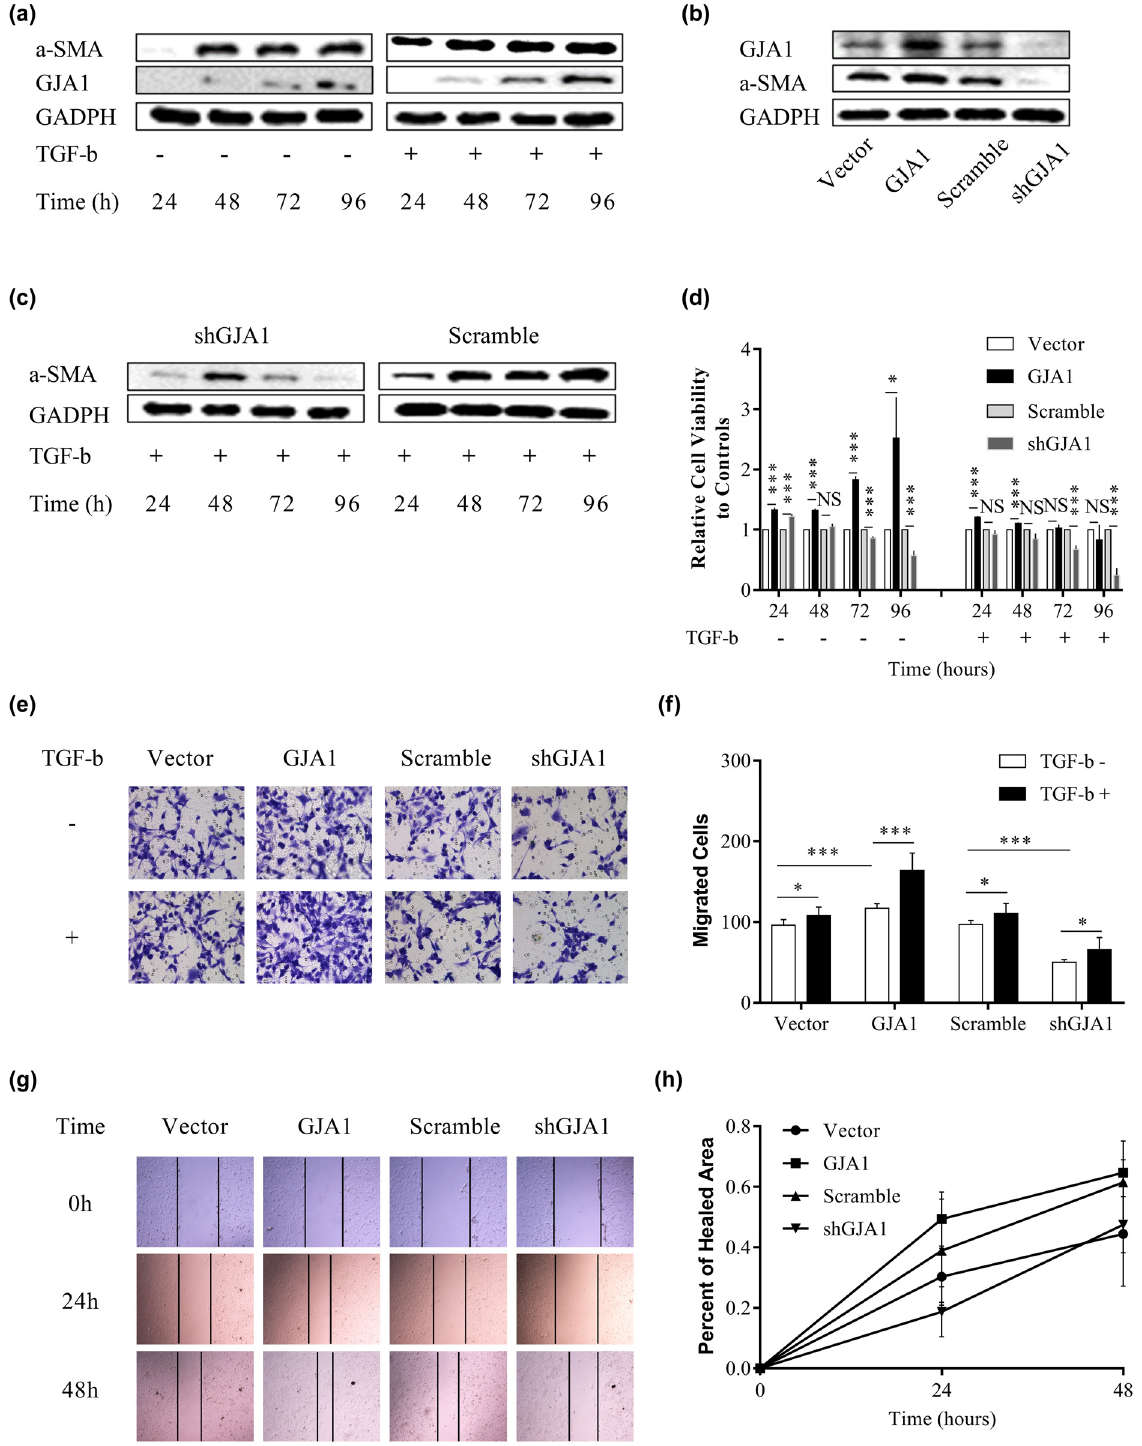
Figure 2: TGF - β - mediated HSC activation and migration are dependent on GJA1. LX2 cells were stimulated with or without TGF - β for 24, 48, 72, and 96h, and cell lysates were collected and analyzed using western blotting with the indicated antibodies ( a ) . Cell lysates were collected from LX2 stableinfectants expressing GJA1, vectorcontrol, shGJA1,orscrambledcontrol,followedbywesternblotting using the indicatedantibodies ( b ) . LX2 stable infectants expressing shGJA1 or scrambled control were stimulated with TGF - β for 24, 48, 72, and 96h, and cell lysates were collected and analyzed by western blotting with the indicated antibodies ( c ) . LX2 stable infectants expressing GJA1, vector control, shGJA1, or scrambled control were seeded into 96 - well plates and stimulated with or without TGF - β for 24, 48, 72, and 96h, followed by cholecystokinin octapeptide - 8 assays ( d ) .LX2 stable infectants expressing GJA1,vectorcontrol, shGJA1,orscrambled controlwere stimulated withorwithout TGF - β for 24h andanalyzed using the Transwell migration assay ( e and f ) . LX2 stable infectants expressing GJA1, vector control, shGJA1, or scrambled control were seeded into 12 - well plates and analyzed using the scratch wound - healing assay. Wound closure was photographed at 0, 24, and 48h and quantitated ( g and h ) . α - SMA, alpha smooth muscle actin; TGF - β , transforming growth factor - β ; HSC, hepatic stellate cell; GJA1, gap junction protein, alpha